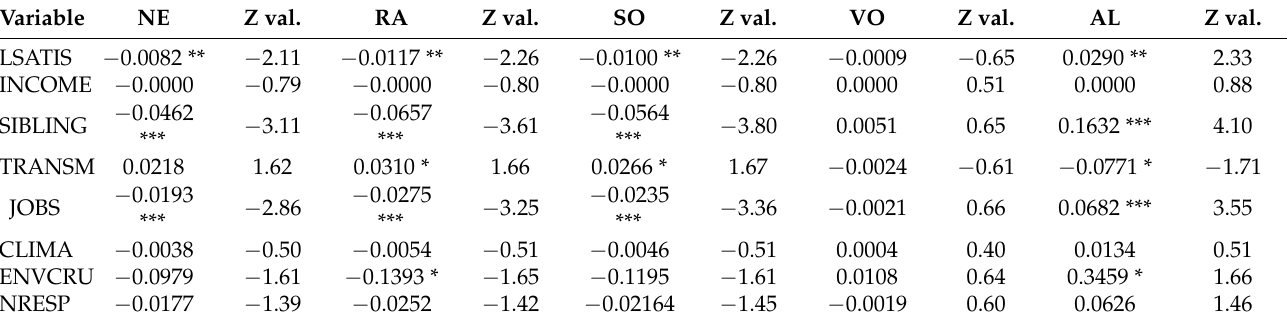
Table 6. Average marginal effects for recycling paper (low-cost PEB).